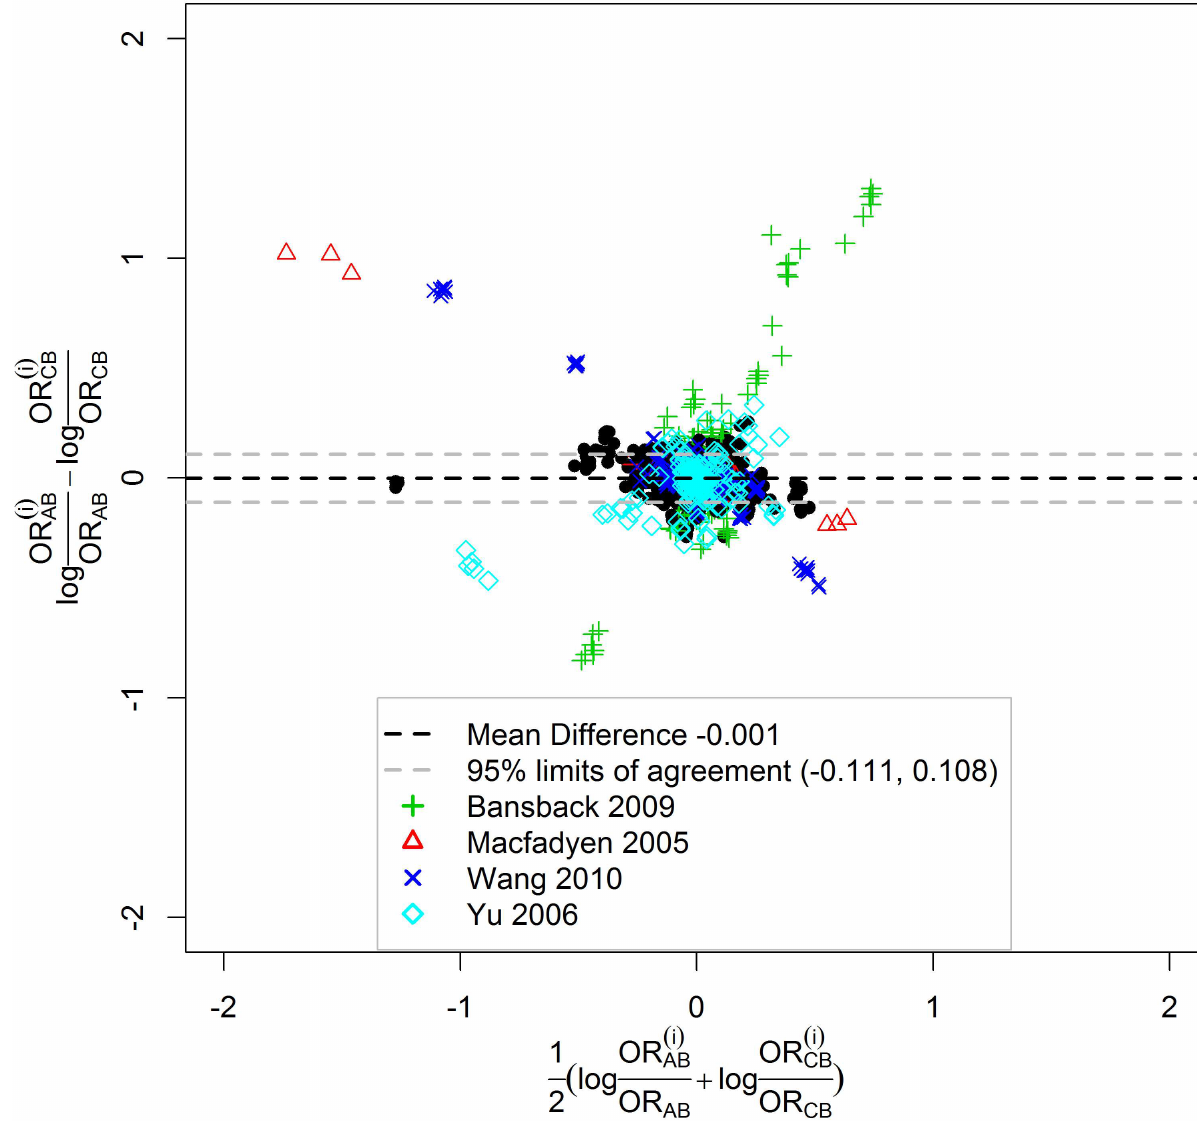
ð i Þ ð i Þ ð log OR þ log OR Þ . The mean difference and 95% limits of agreementare shown in CB AB 2 OR AB OR CB